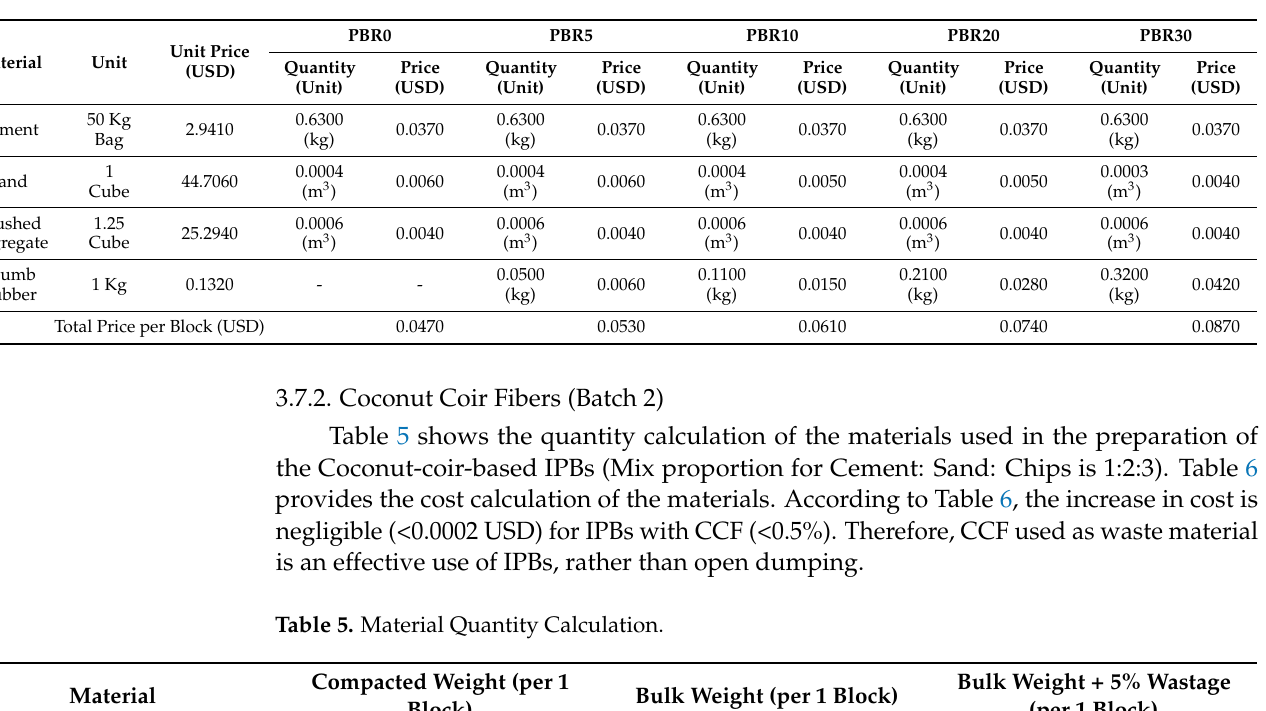
Table 4. Cost analysis per CR-based IPB (200 × 100 × 60 mm).